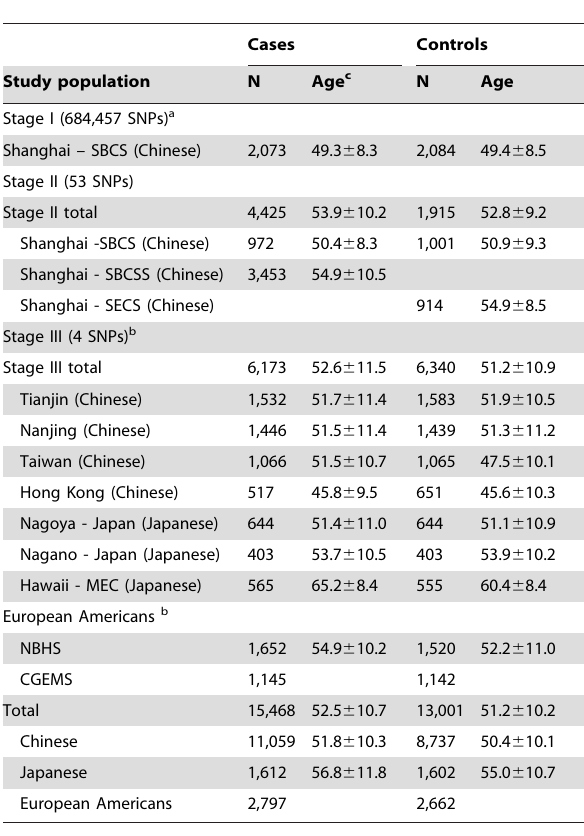
Table 1. Characteristics of study participants and number of SNPs analyzed in each